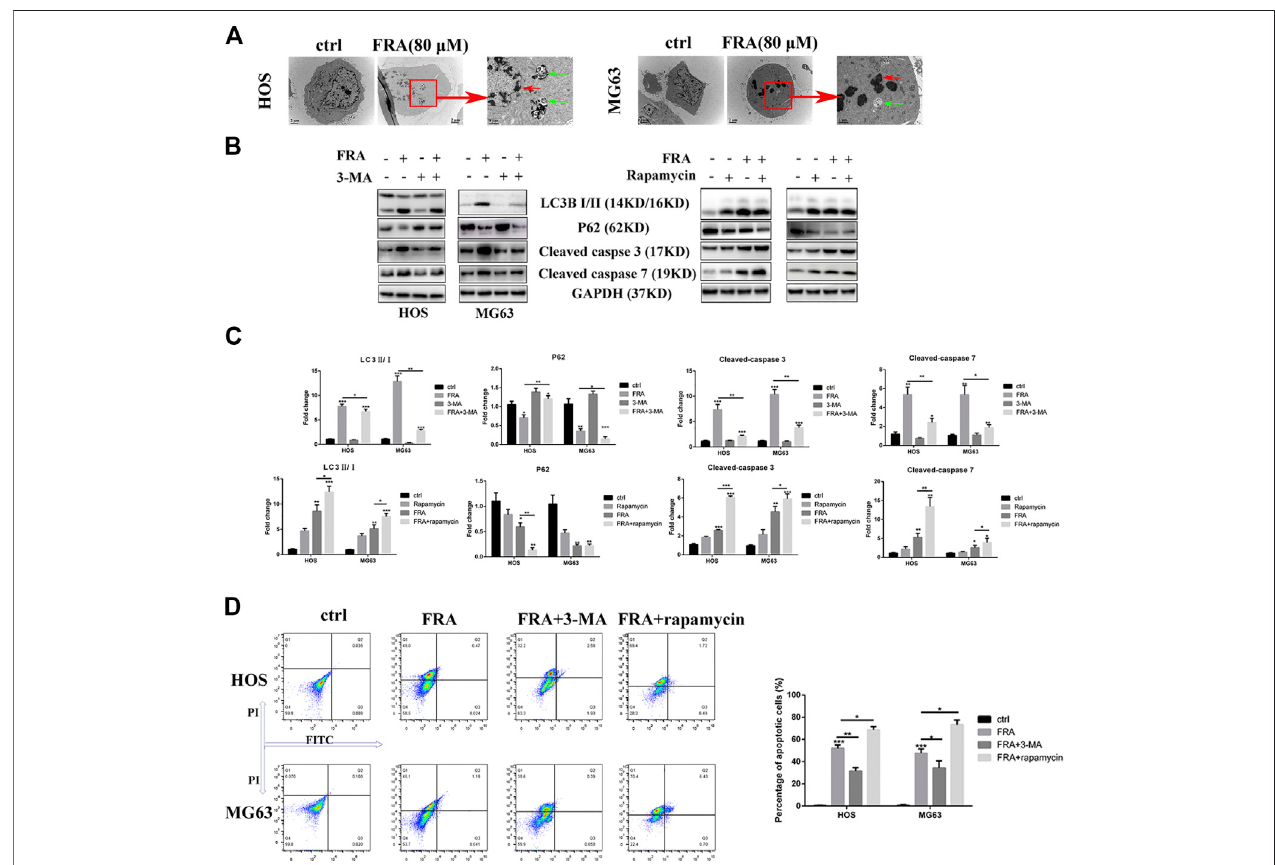
FIGURE4| FRAinducescellapoptosis bypromotingexcessiveautophagy fl ux. (A) Transmission electron microscopy (TEM)showsthemorphologicalchangesin cells induced treated with FRA. The red arrows mean apoptotic bodies and nuclear condensation. The green arrows mean autophagosomes. Magni fi cation, × 10,000, Scale bar, 2 μ m. HOS and MG63 cells were treated with or without FRA (8 μ M), with or without 3-MA (3 mM), or with or without rapamycin (100 nM) for 24 h. (B) The protein expressions of LC3B, p62, cleaved-caspase 3 and cleaved-caspase 7 were measured by Western blotting. (C) The corresponding histogram statistics of these proteins. Each assay was repeated three times. (D) . The cells after different treatments were stained with the Annexin FITC/PI kit, and then the percentage of apoptotic cells was detected by fl ow cytometry. Error bar (cid:2) mean ± SD. * p < 0.05, ** p < 0.01, *** p < 0.001 versus control.